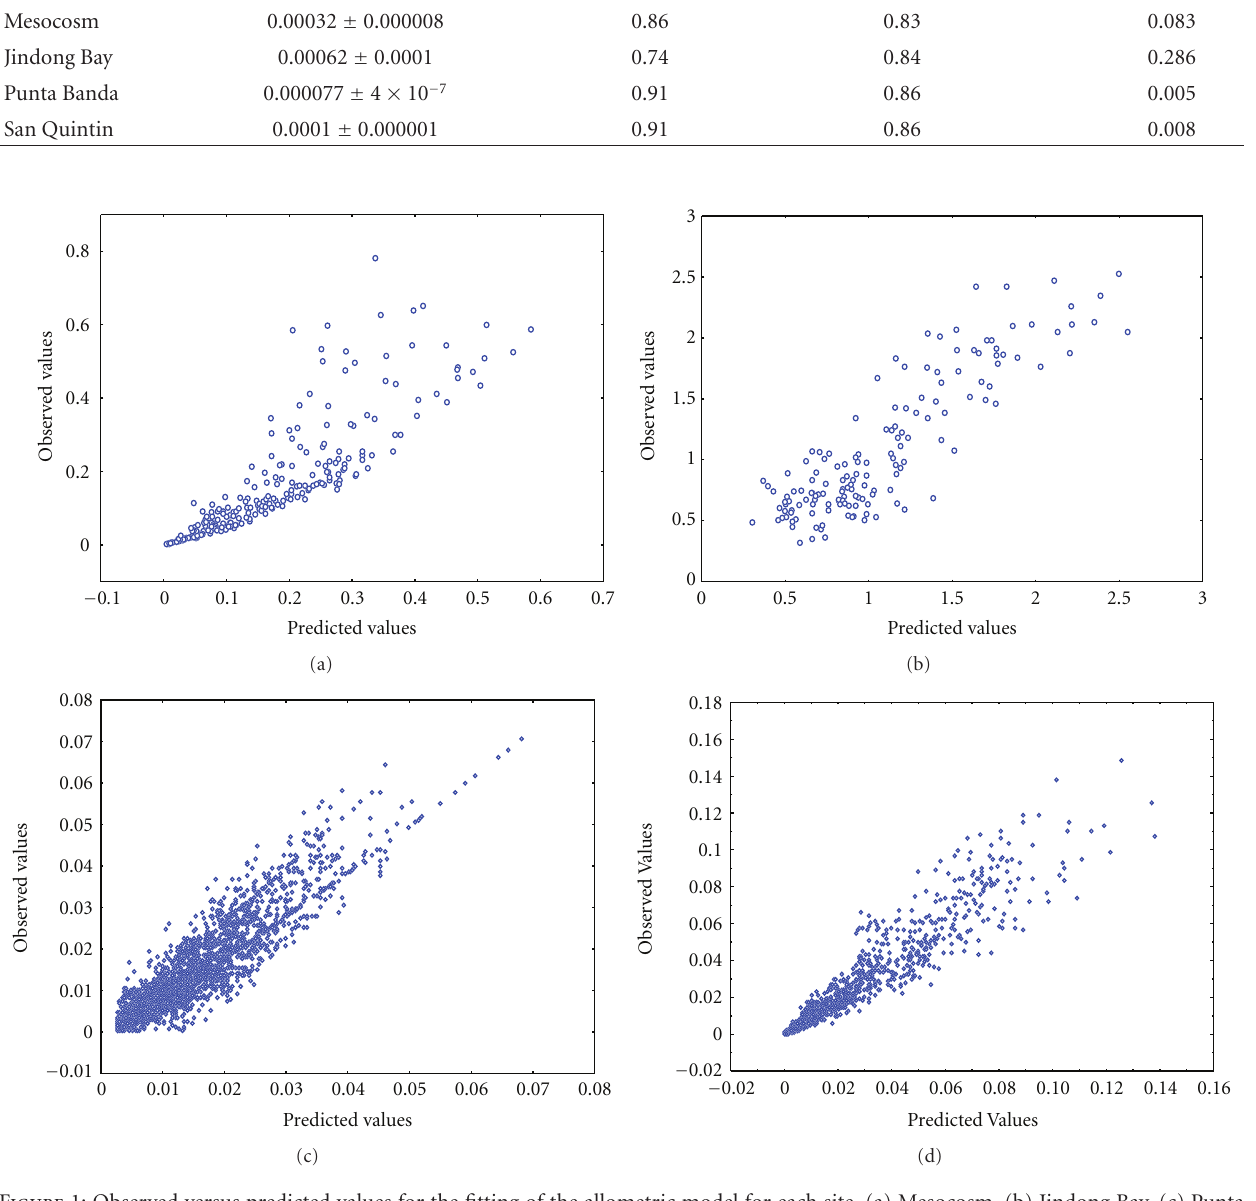
Figure 1: Observed versus predicted values for the fitting of the allometric model for each site. (a) Mesocosm, (b) Jindong Bay, (c) Punta Banda estuary, and (d) San Quintin